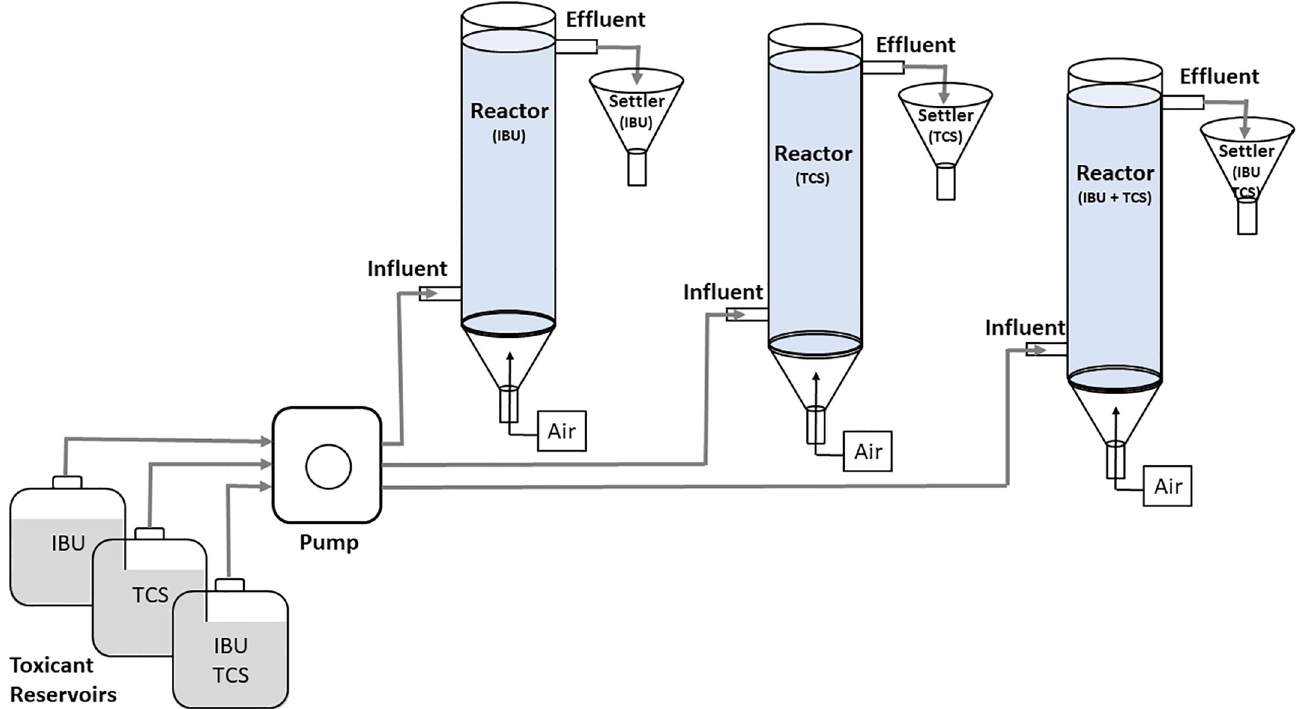
Fig 1. Diagram of the activated sludge laboratory